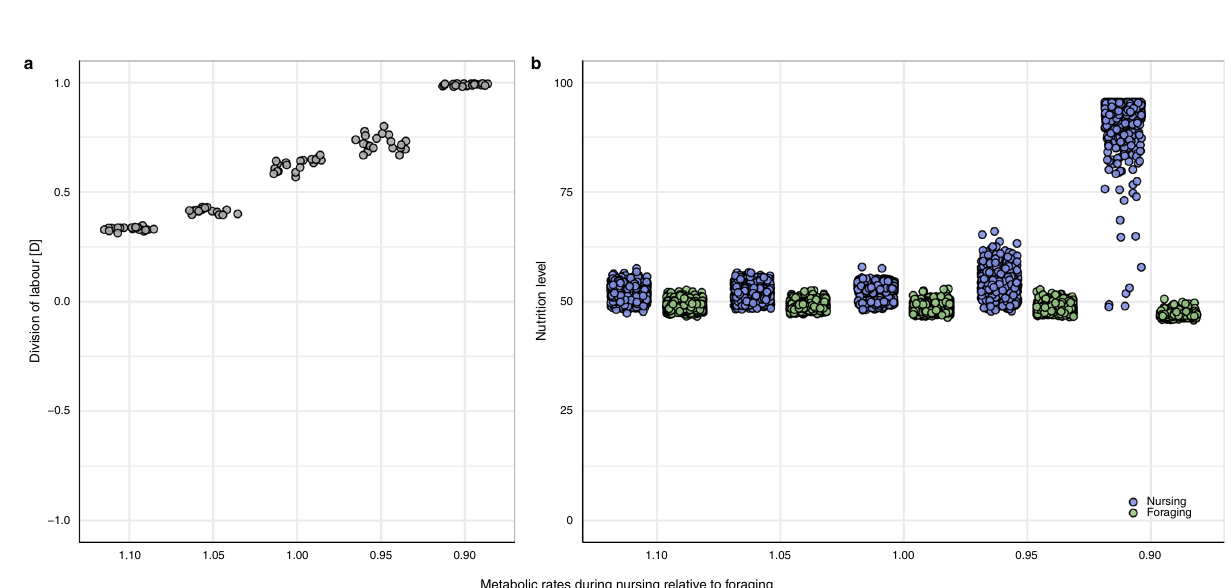
foraging individuals share their collected resources equally with nursing indivi- duals, D ≈ 0.6 which represents an intermediate level of division of labour. Each grey dot (left panel) is the division of labour metric from a replicate simulation ( n =20). Blue (nursing) and green (foraging) dots (right panel) represent the nutrition levels of all individuals at the end of all replicate